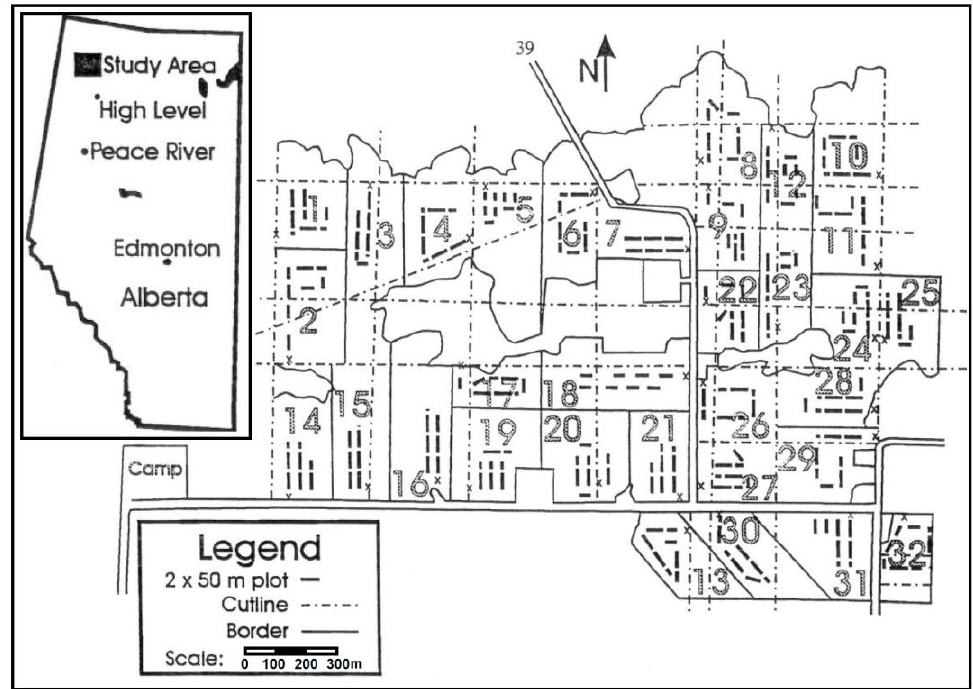
Figure 1. A schematic representation of the Zama silvicultural installation. 344 ha of treatment compartments are distributed randomly over an area roughly 2.5 km x 1.5 km (375 ha) in size.